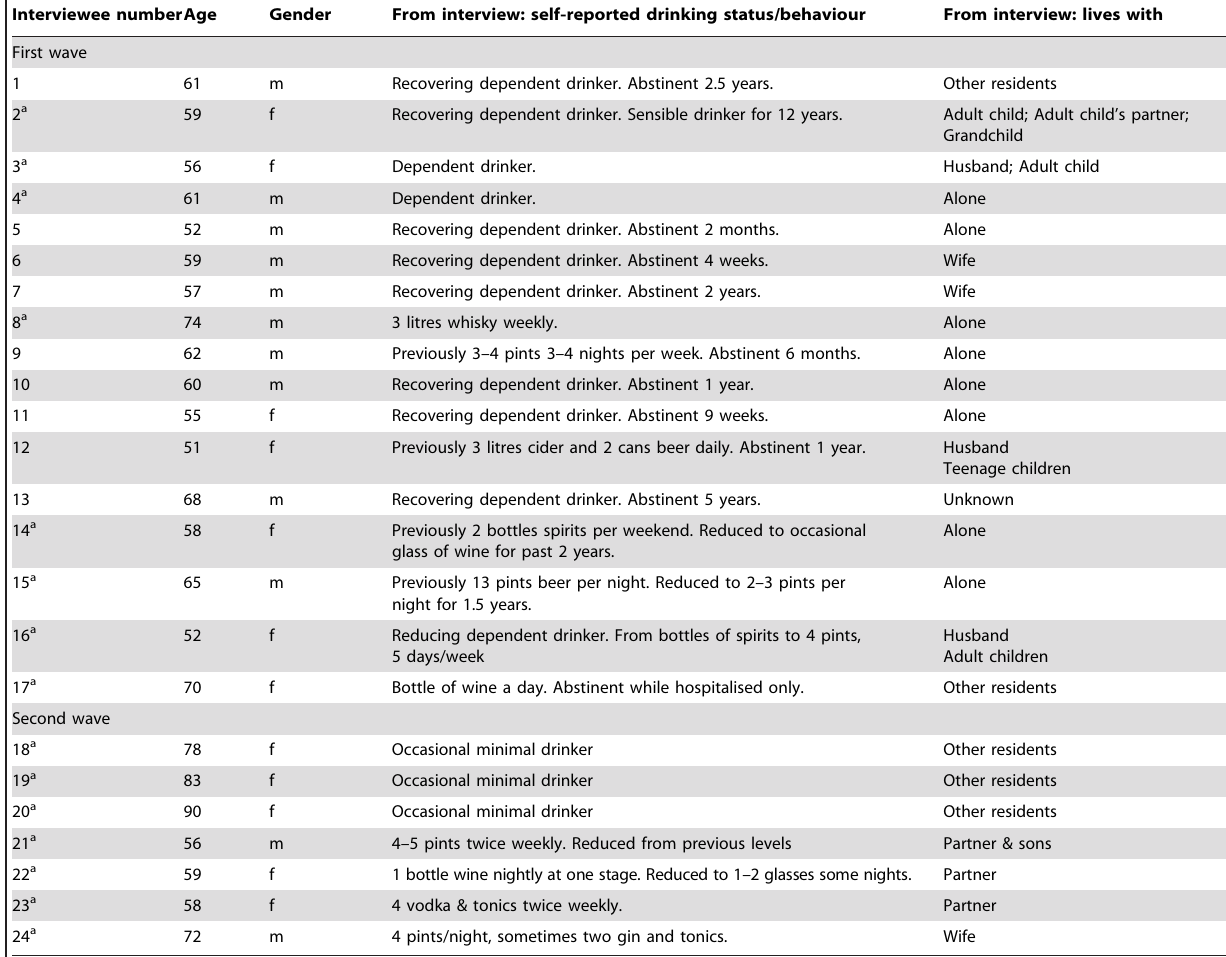
Table 1. Interviewee